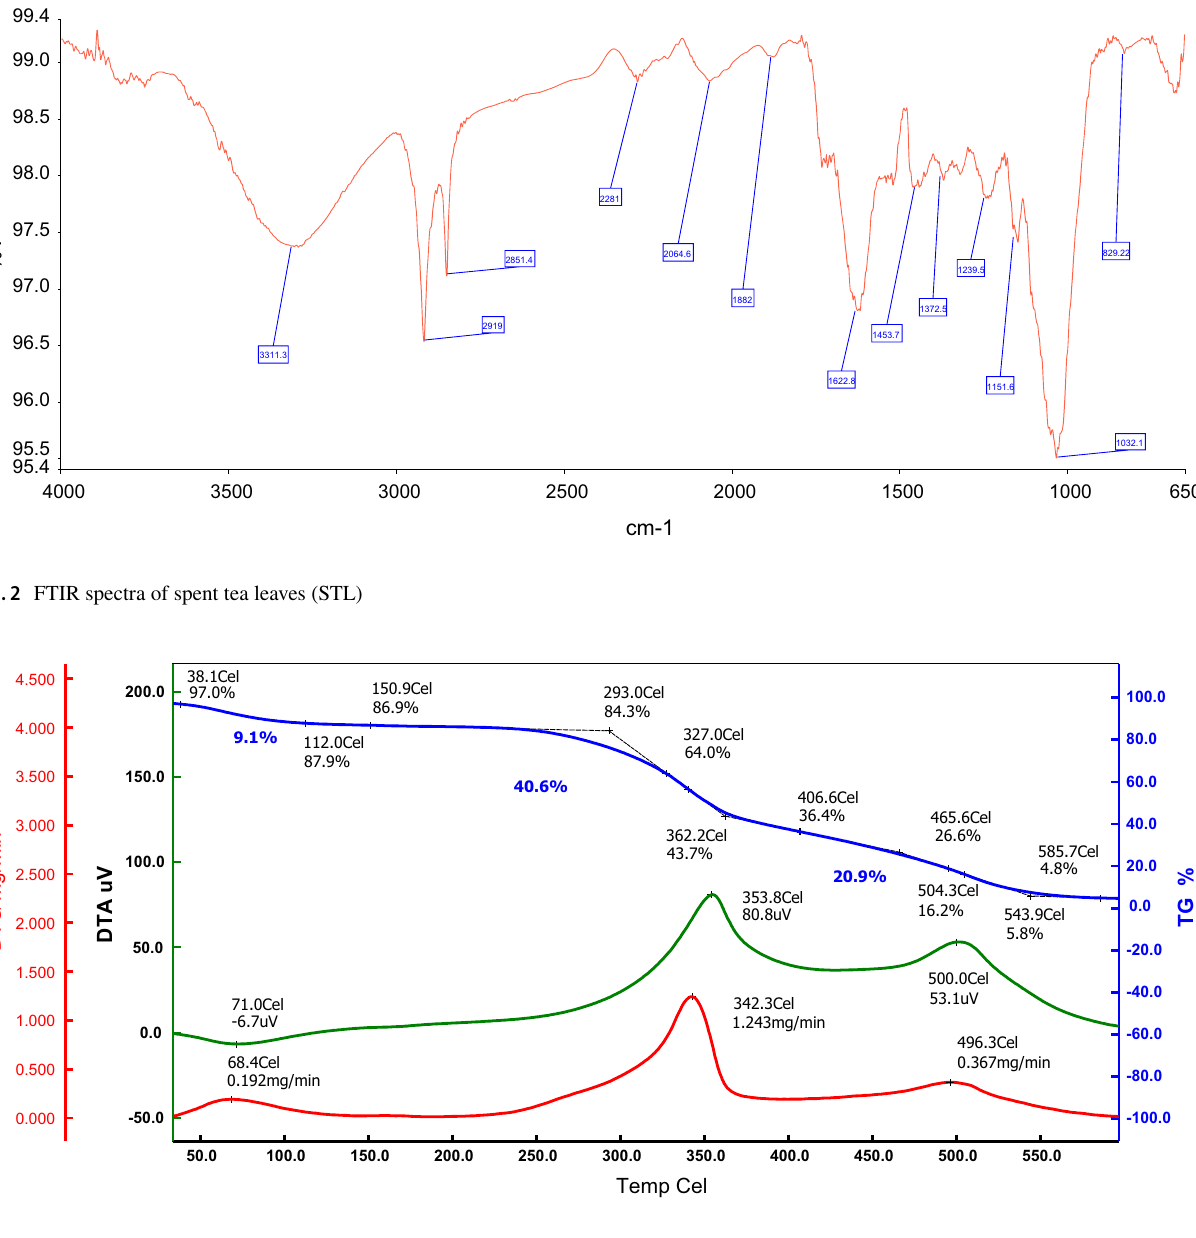
Fig. 3 TGA of spent tea